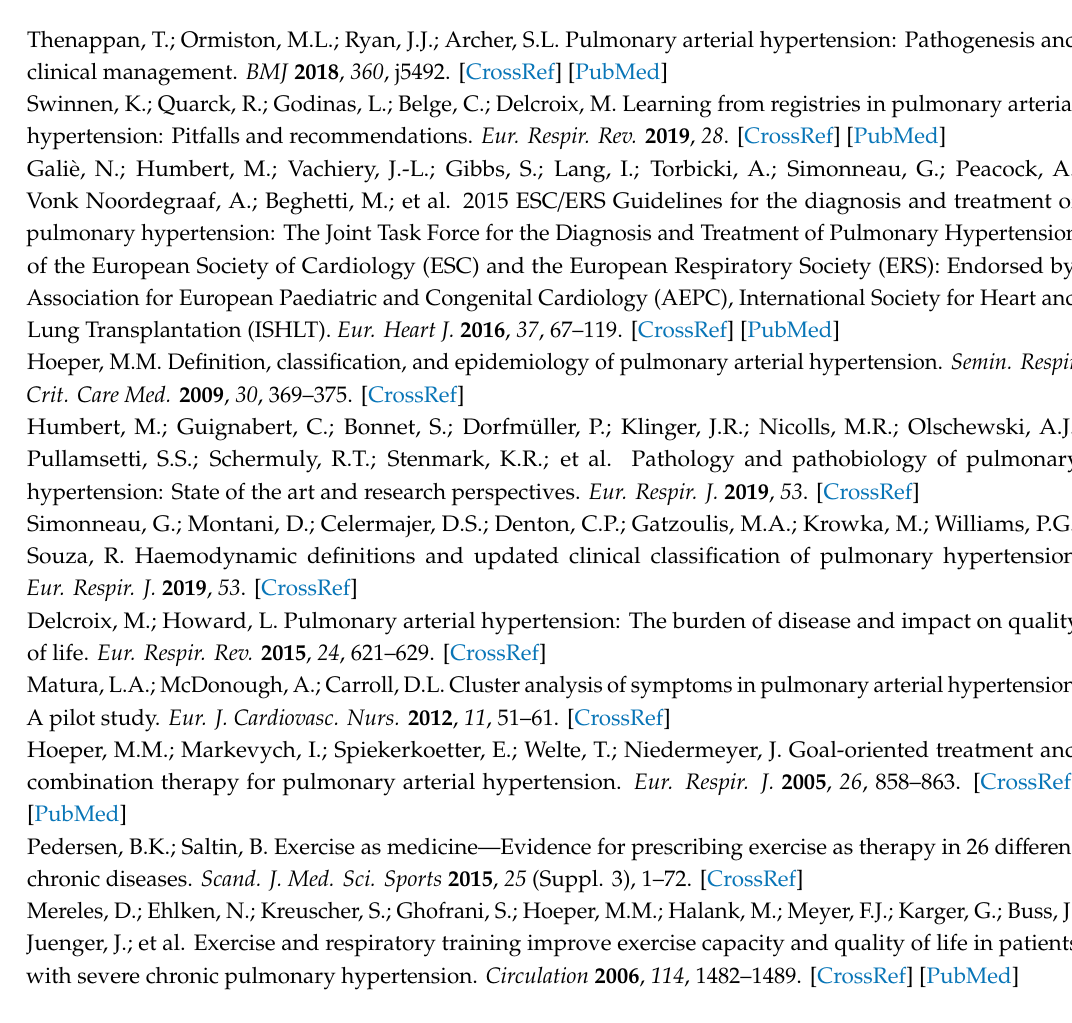
Table S1: Overview on the headings and search terms used for this systematic review. Table S2: Detailed search strategy including date, searched databases, and keywords. Table S3: Functional classification of patients in human studies. Table S4: Detailed list of reporting of adverse